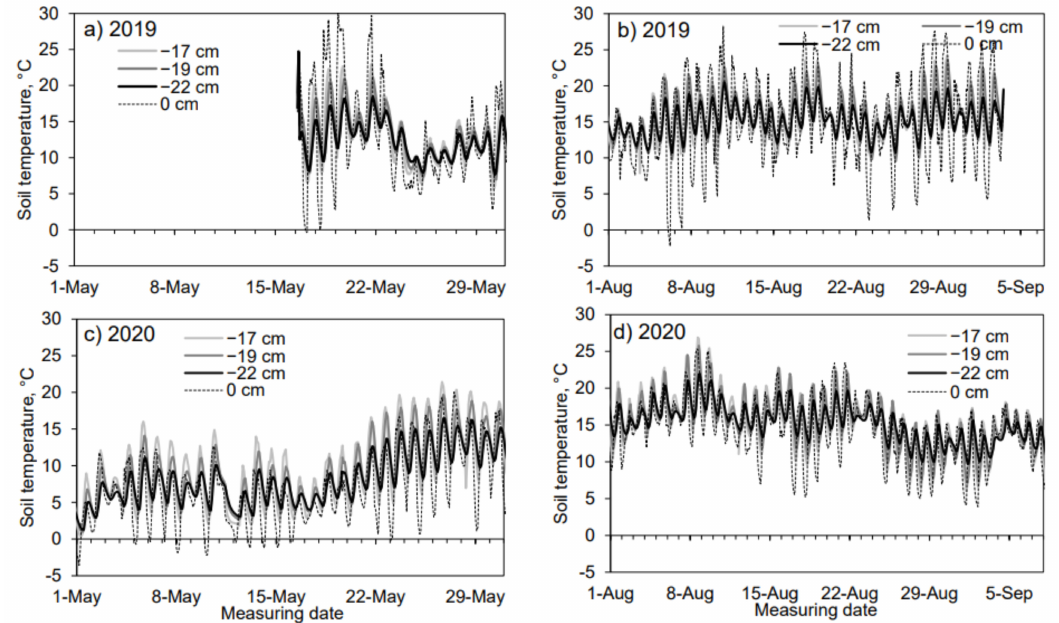
Figure 1. Soil temperatures in spring ( a , c ) and autumn ( b , d ) of 2019 and 2020, respectively, at different planting depths in Experiment 2 in Scots